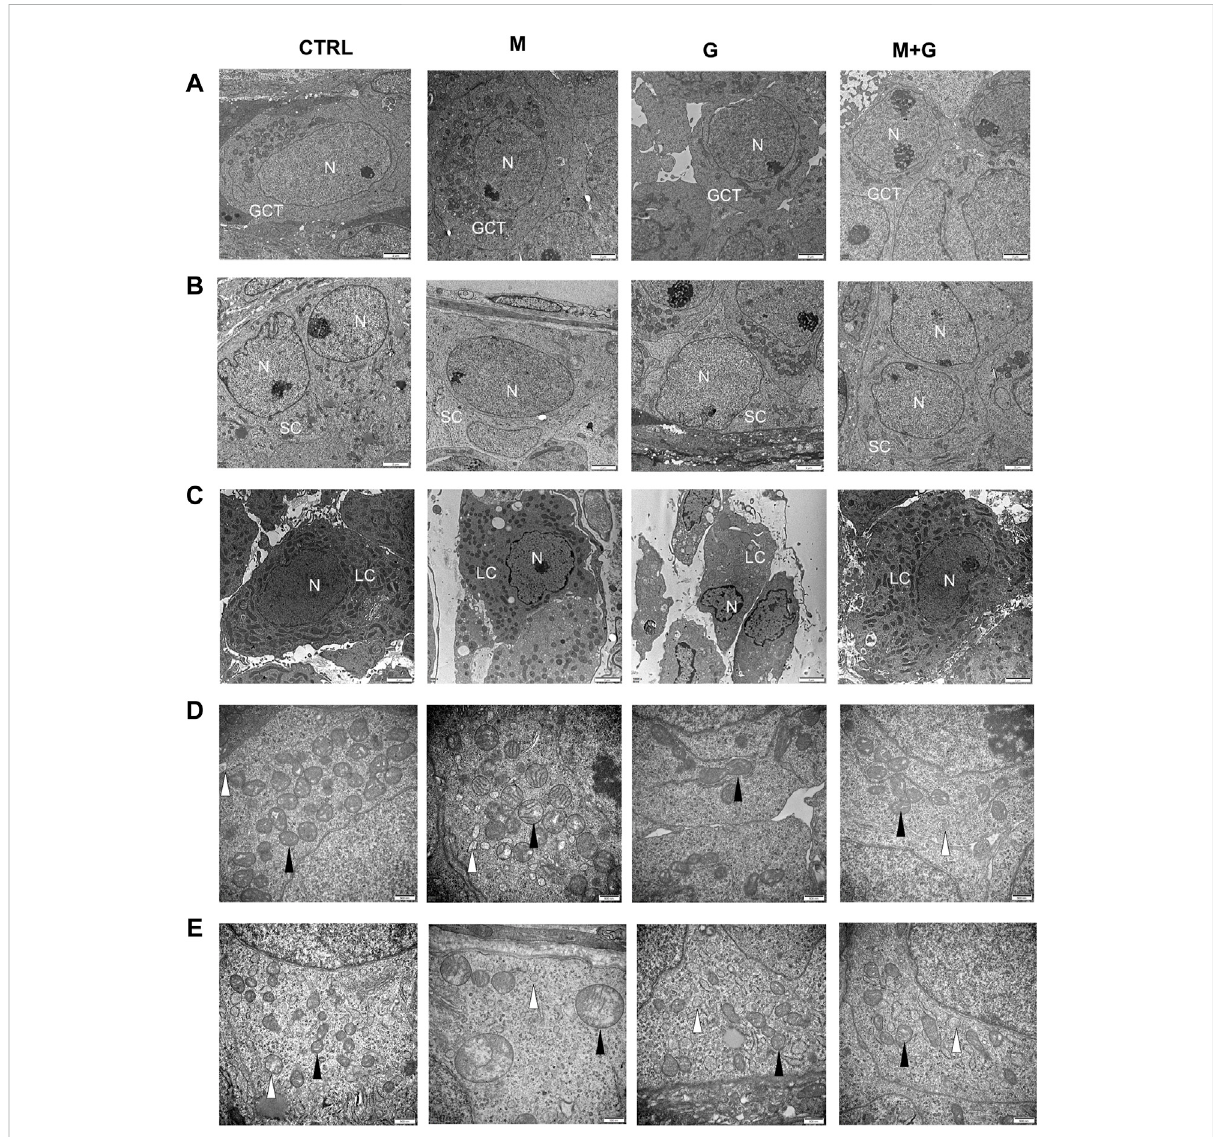
FIGURE 10 Ultrastructural analysis of the cultured testis. Mitochondria swelling in the gonocytes and Sertoli cells was found after MEHP exposure for 4 days. By contrast, gonocytes, and Sertoli cell in control, group G and M + G exhibited normal ultrastructure. Leydig cells in all groups exhibited normalultrastructureandintactbasementmembraneweresustained.GCT,gonocytes;SC,Sertolicells;LC,Leydigcells;N,nuclei; ▲ ,mitochondria; Δ , endoplasmic reticulum. (A) gonocytes; (B) Sertoli cells; (C) Leydig cells; (D) mitochondria of gonocytes; (E) mitochondria of Sertoli cells. (A – C) ×10,000 magni fi cation, scale bars indicate 2 μ m; (D,E) ×30,000 magni fi cation, scale bars indicate 500